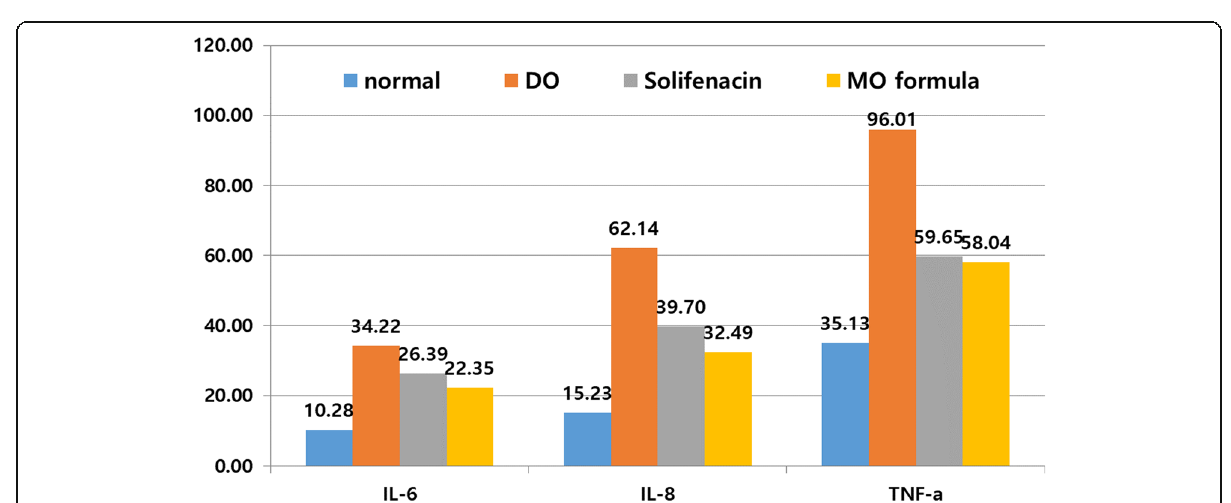
Fig. 6 proinflammatory cystokine